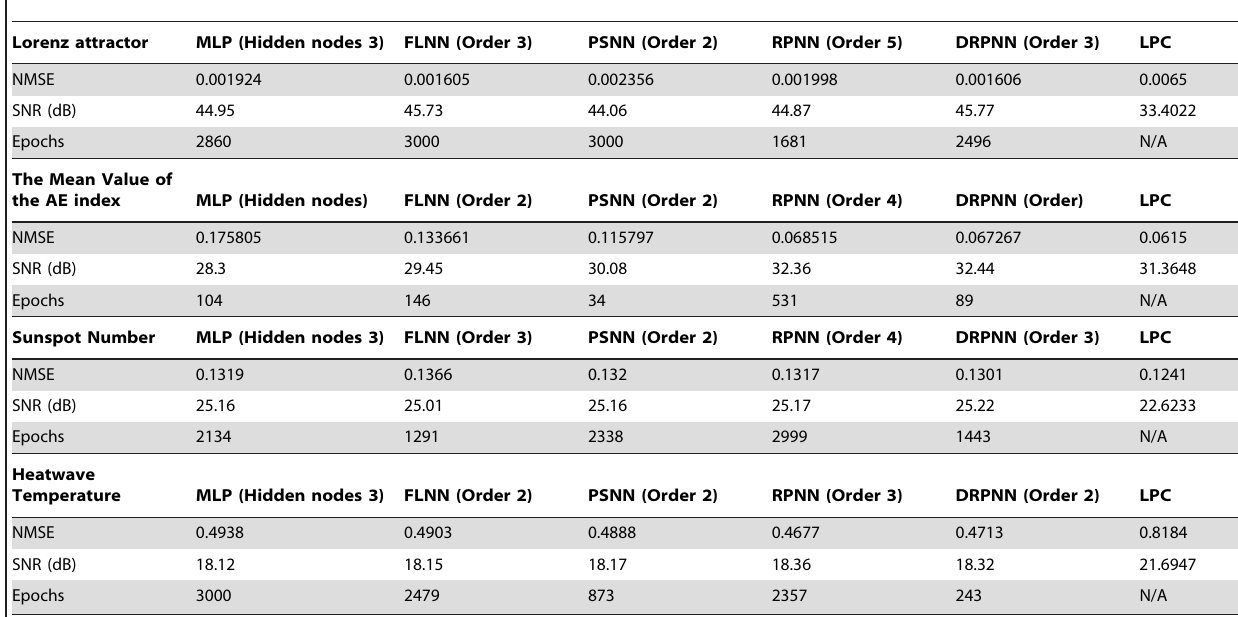
Table 2. The average simulation results over 5 trials using the benchmarked Neural Networks Structures and the simulation results using Linear Predictor Coefficient (LPC)